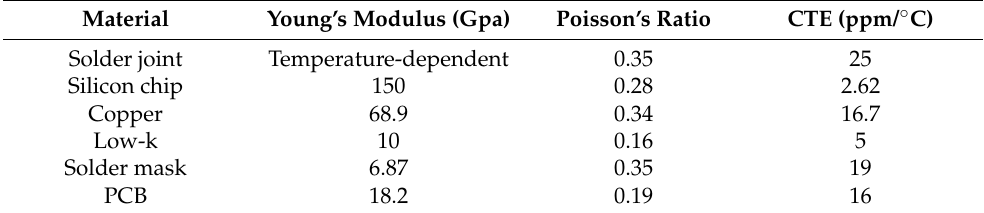
Table 3. Material properties of WLP.